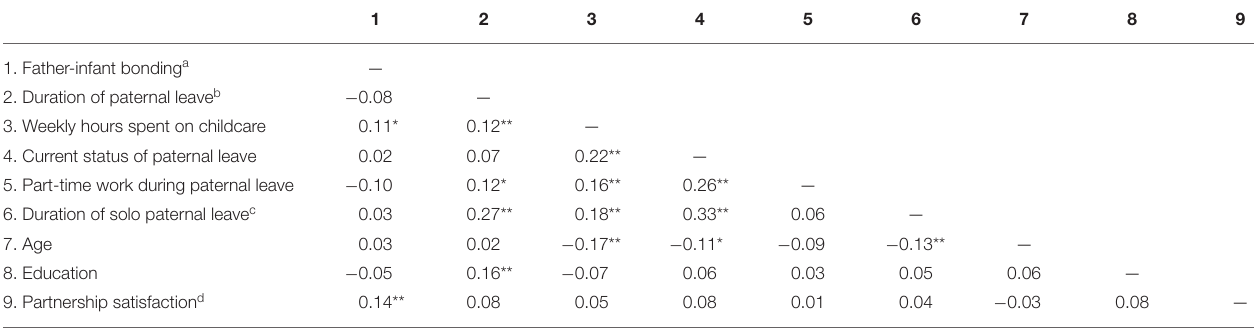
TABLE 2 | Intercorrelations between study variables.